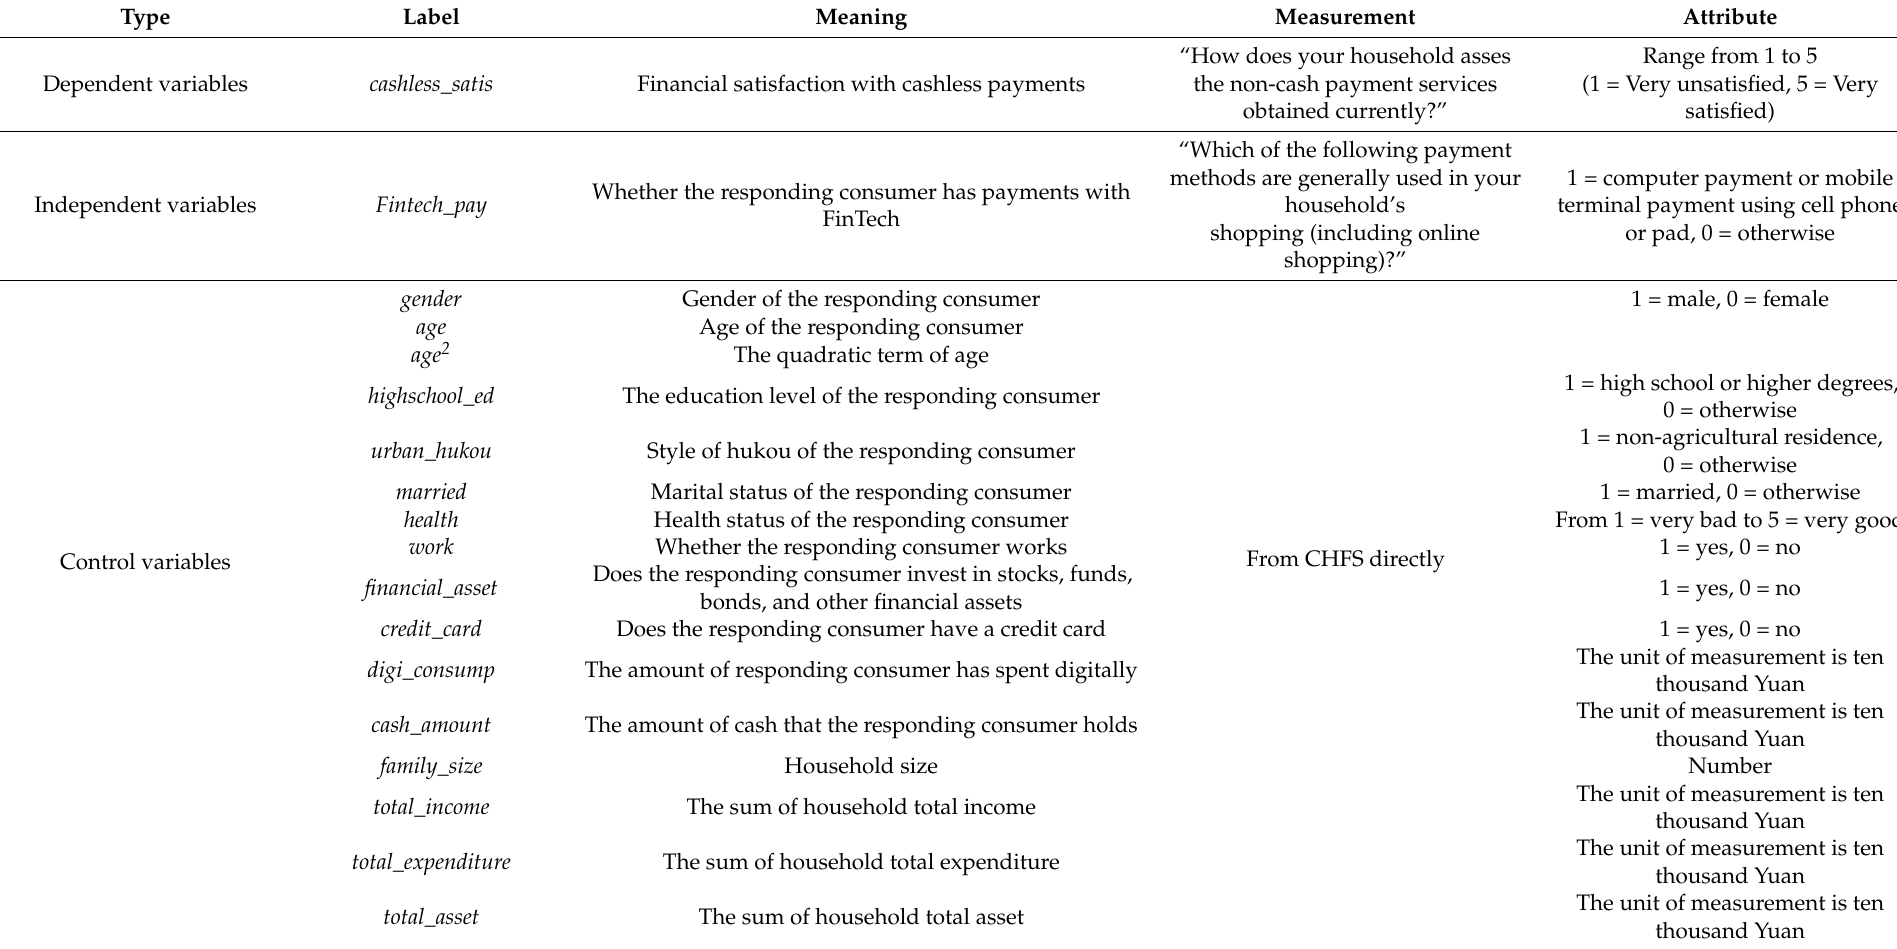
Table 1. Specifications of